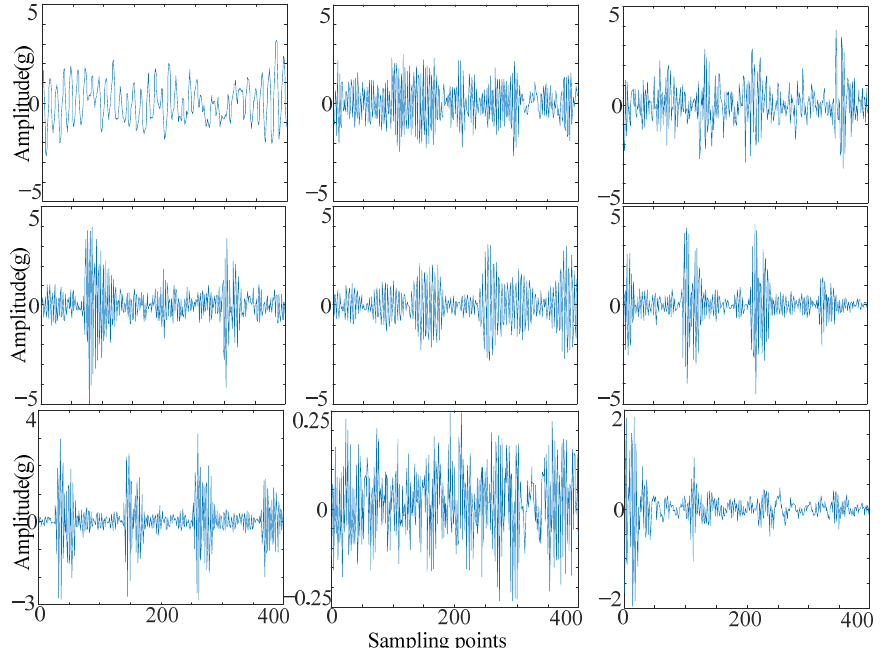
Figure 6. Acceleration signals for the nine types of faults on the drive end. In the process of the experimental validation, after many experiments and analyses, we have given a range for the selection of the parameters. First, for the two parameters, ζ and MinPts, of DBSCAN, we know that, for the minimum distance, ζ , if the value is set too large, the denoising effect will not be achieved; if it is too small, the total number of categories will be too large. Therefore, after several choices, we decided to select the maximum standard deviation of all samples within the batch as the basis. The best results are achieved when set to 0.3–0.4 times. For the parameter MinPts , the aim is to achieve the best possible filtering effect, and we want the valid samples to be clustered together as much as possible. Therefore, we assume that the gradient information is useful for most of the samples, and when its multiplicity is set to 1, it is the normal MGD algorithm. During the experiments we found that, if the parameter was set too large, the clustering result was similar to MGD. If it was too small, there will be many clusters, and the denoising performance will be poor. Therefore, we suggest 0.3–0.5 times the BatchSize to speed up clustering and effectively achieve the effect of noise removal. It has little impact on the iteration rate of the network. The connection values for the top 50% of the network are set to use the proposed algorithm in the paper for gradient